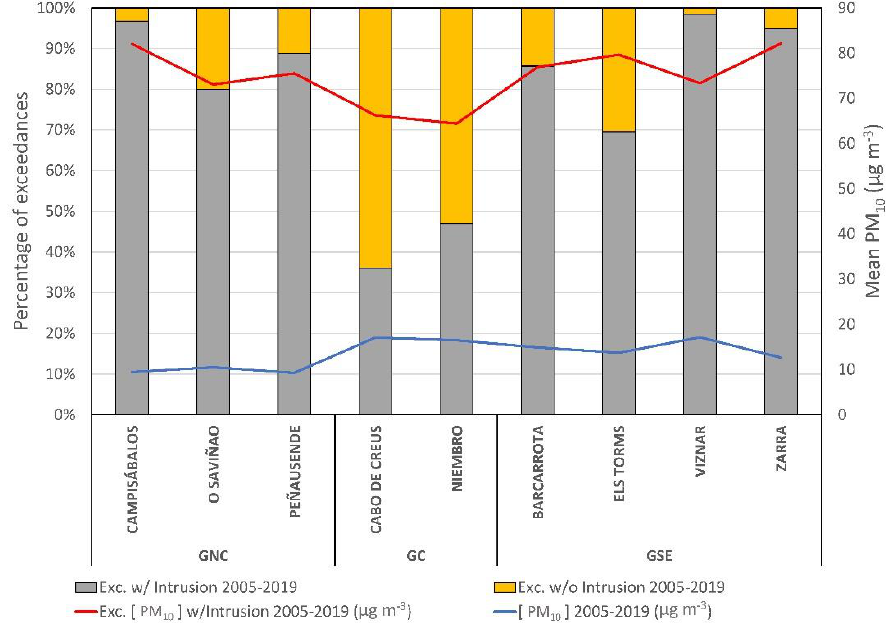
Figure 5. Relationship between the percentage of days exceeding the daily threshold value related (gray column) or not (orange column) with Saharan dust intrusions for the period 2005–2019. Mean PM 10 concentrations for the days exceeding the daily threshold value for the whole measuring period (blue line) and for the values related to intrusions (red line) are also shown.